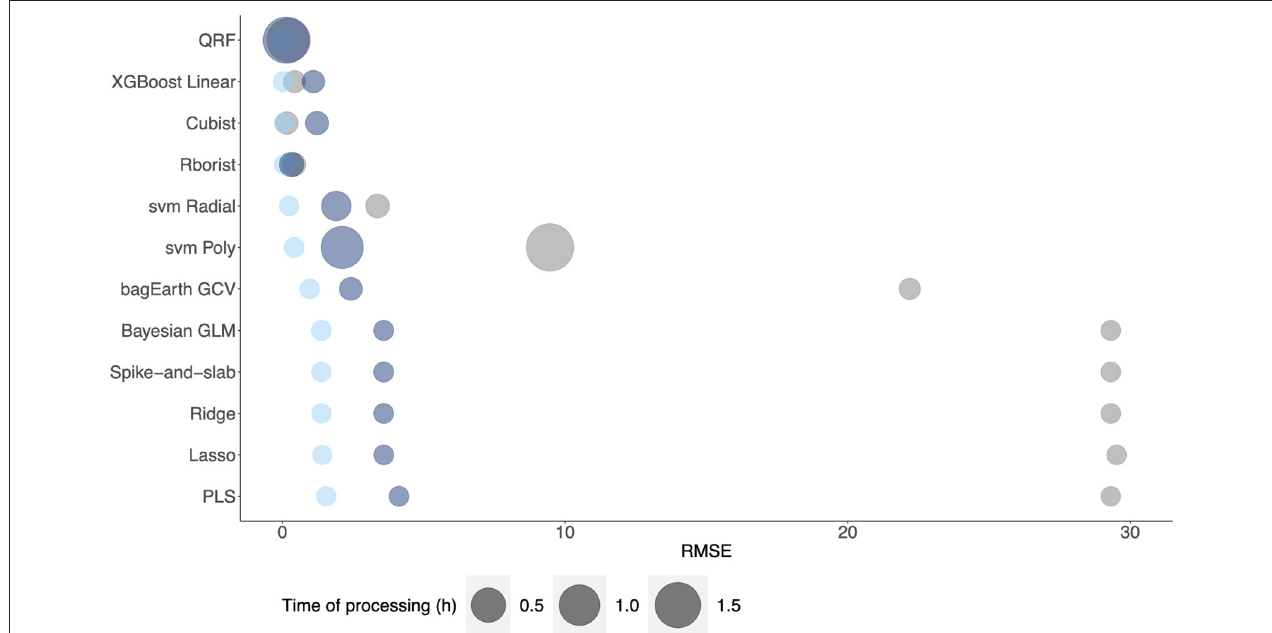
FIGURE 10 | Comparison of model processing time against RMSE of each dataset: Dataset 1 (gray), Dataset 2 (light blue) and Dataset 3 (dark blue) for metabolic flux